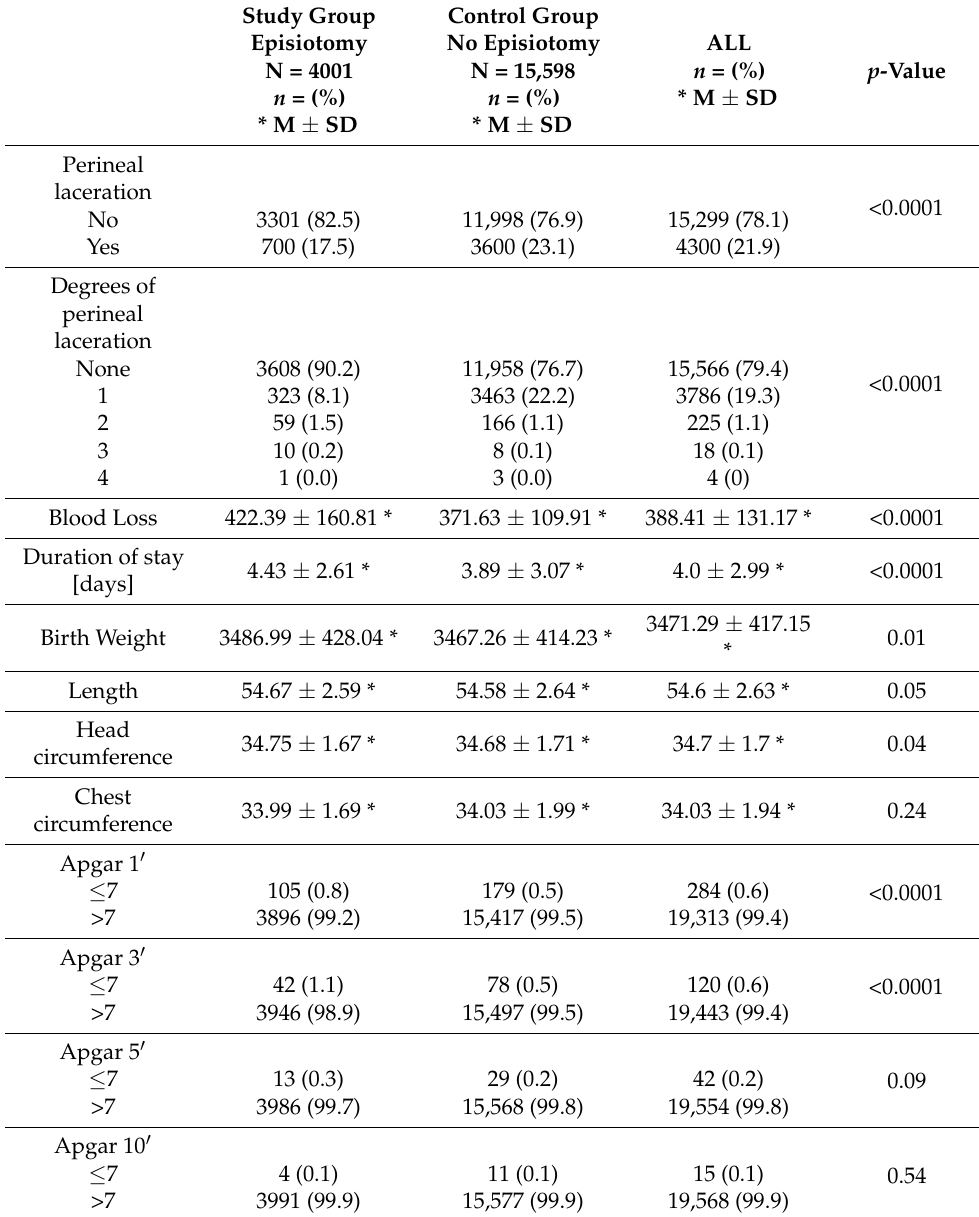
Table 3. Analysis of the incidence of perineal incisions among the selected variables occurring after